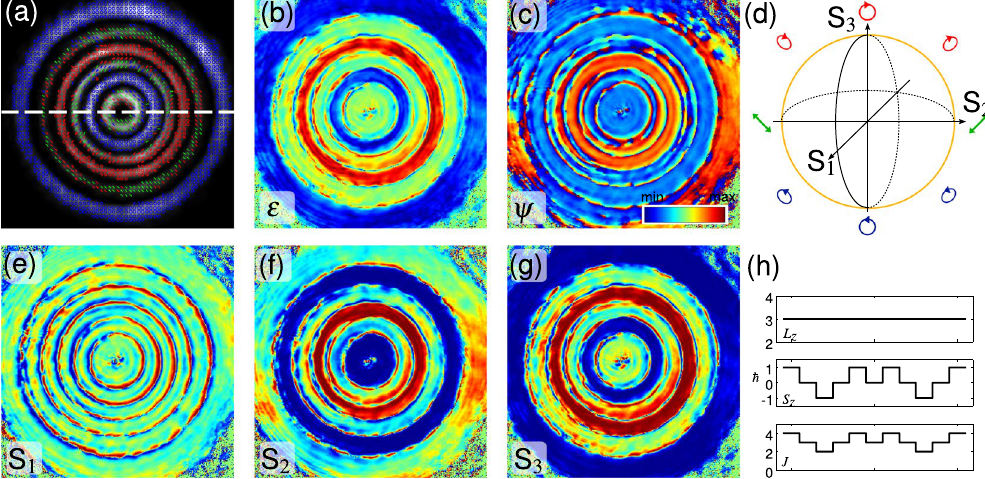
Figure 2. Spatial polarization modulation of a helical LG 5,3 beam: ( a ) Polarization ellipses based on measured Stokes parameters S 1,2,3 ∈ [ − 1, 1] shown in ( e – g ). Ellipticity ε ∈ [ − 1, 1] and orientation ψ ∈ [ − π /2, π /2] of polarization states are given in ( b ) and ( c ). ( d ) Sketch of employed subspace of DPMS. ( h ) Distribution of spin ( S z ), orbital ( L z ) and total ( J ) angular momentum per photon along the white dashed line in ( a